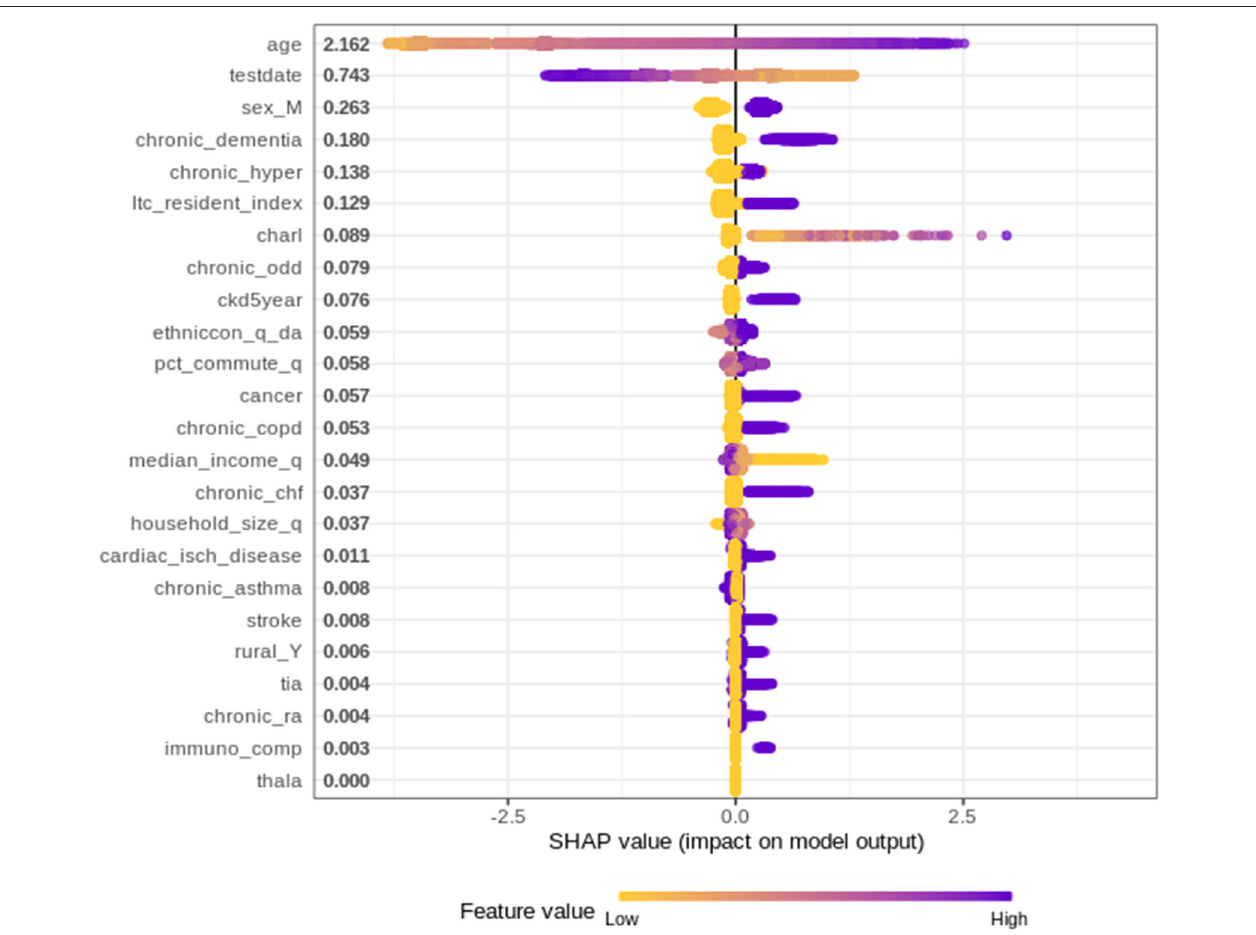
FIGURE 1 | SHAP summary plot for XGBoost